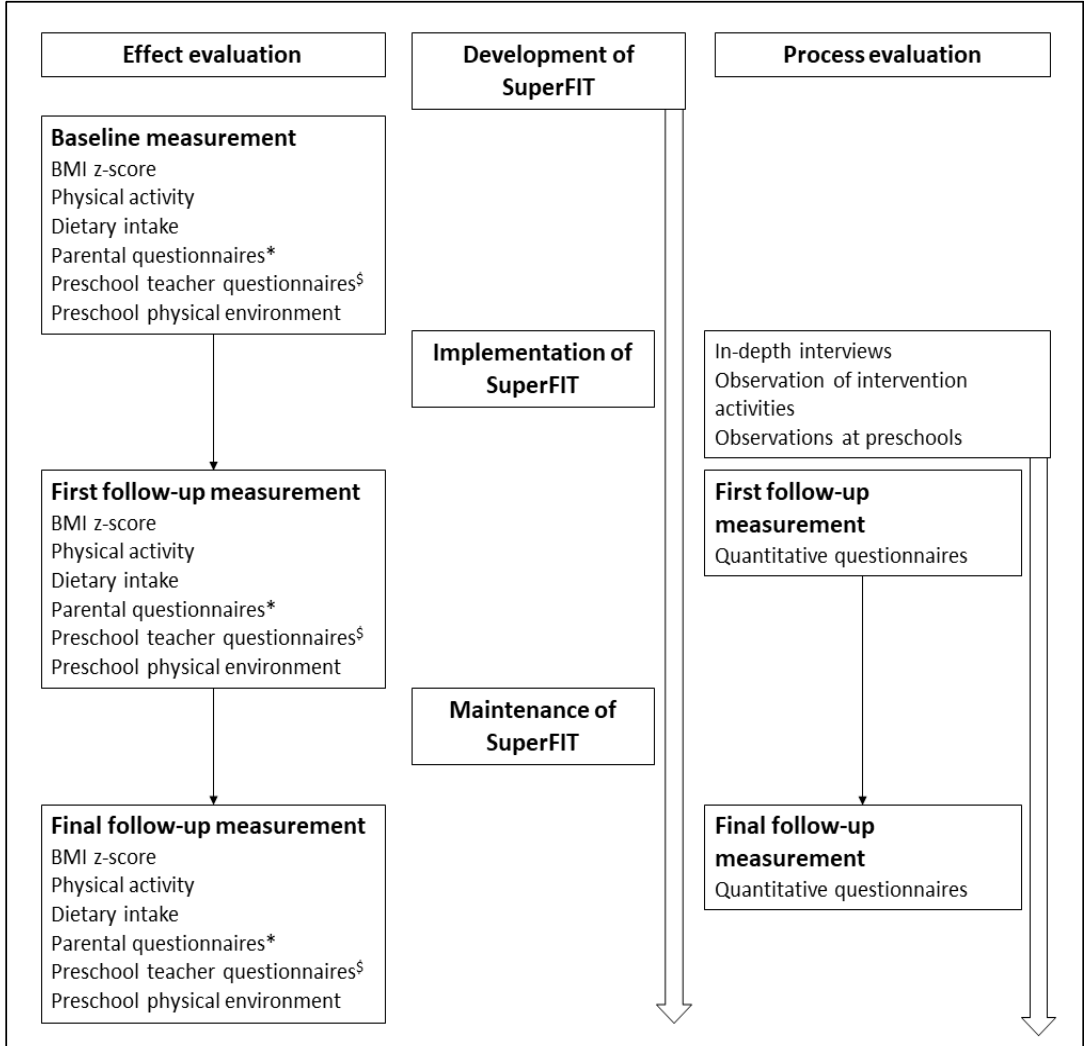
Figure 1. Planning of the implementation and evaluation of SuperFIT (Systems of Underprivileged Preschoolers in their home and preschool EnviRonment: Family Intervention Trial). * Parental questionnaires measured demographics, nutritional and physical-activity-related practices, family health climate and physical home environment. $ Preschool teacher questionnaires measured demographics and nutritional and physical-activity-related